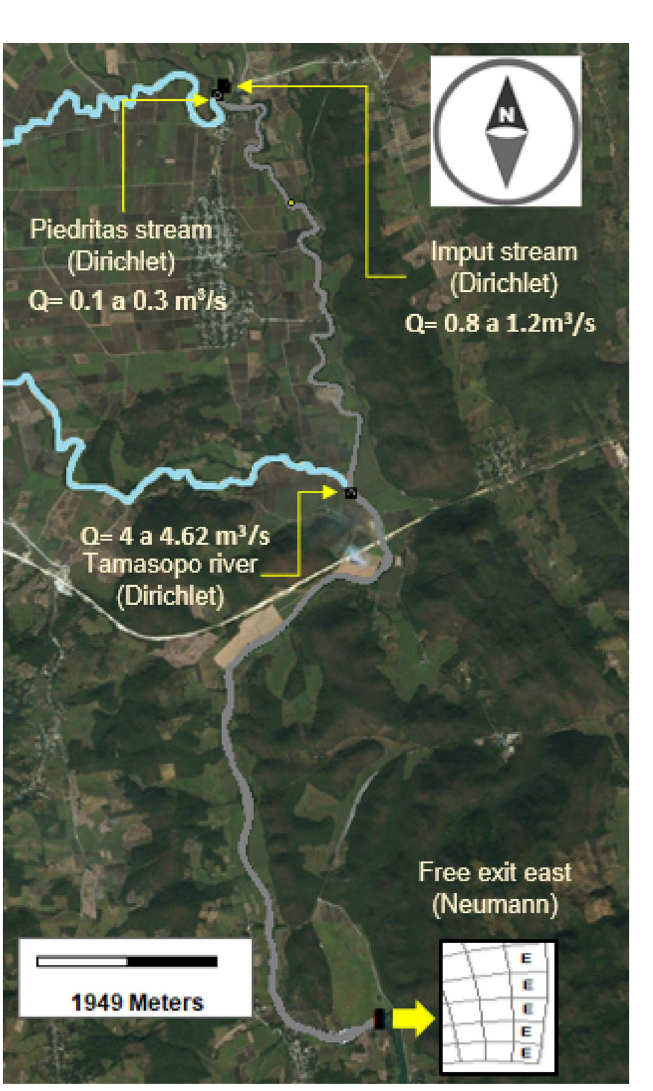
Figure 5. Inflow and outflow conditions, imposed in the Gallinas River. This figure was generated using the post-processing visualization tool of the EFDC Explorer (https:// www. eemod eling system.